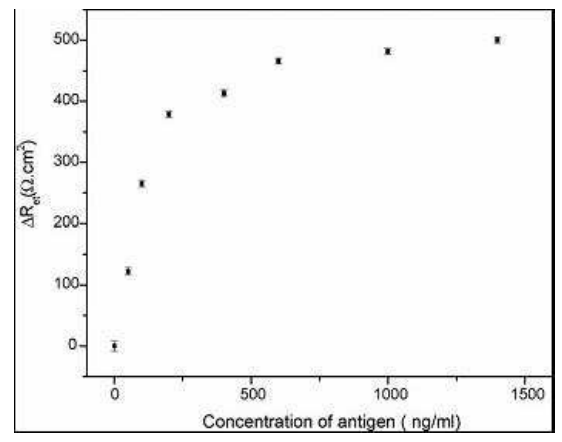
Figure 4. Calibration plot of the variation of electron transfer resistance D R atrazine ( Reprinted from [7] with permission from Elsevier